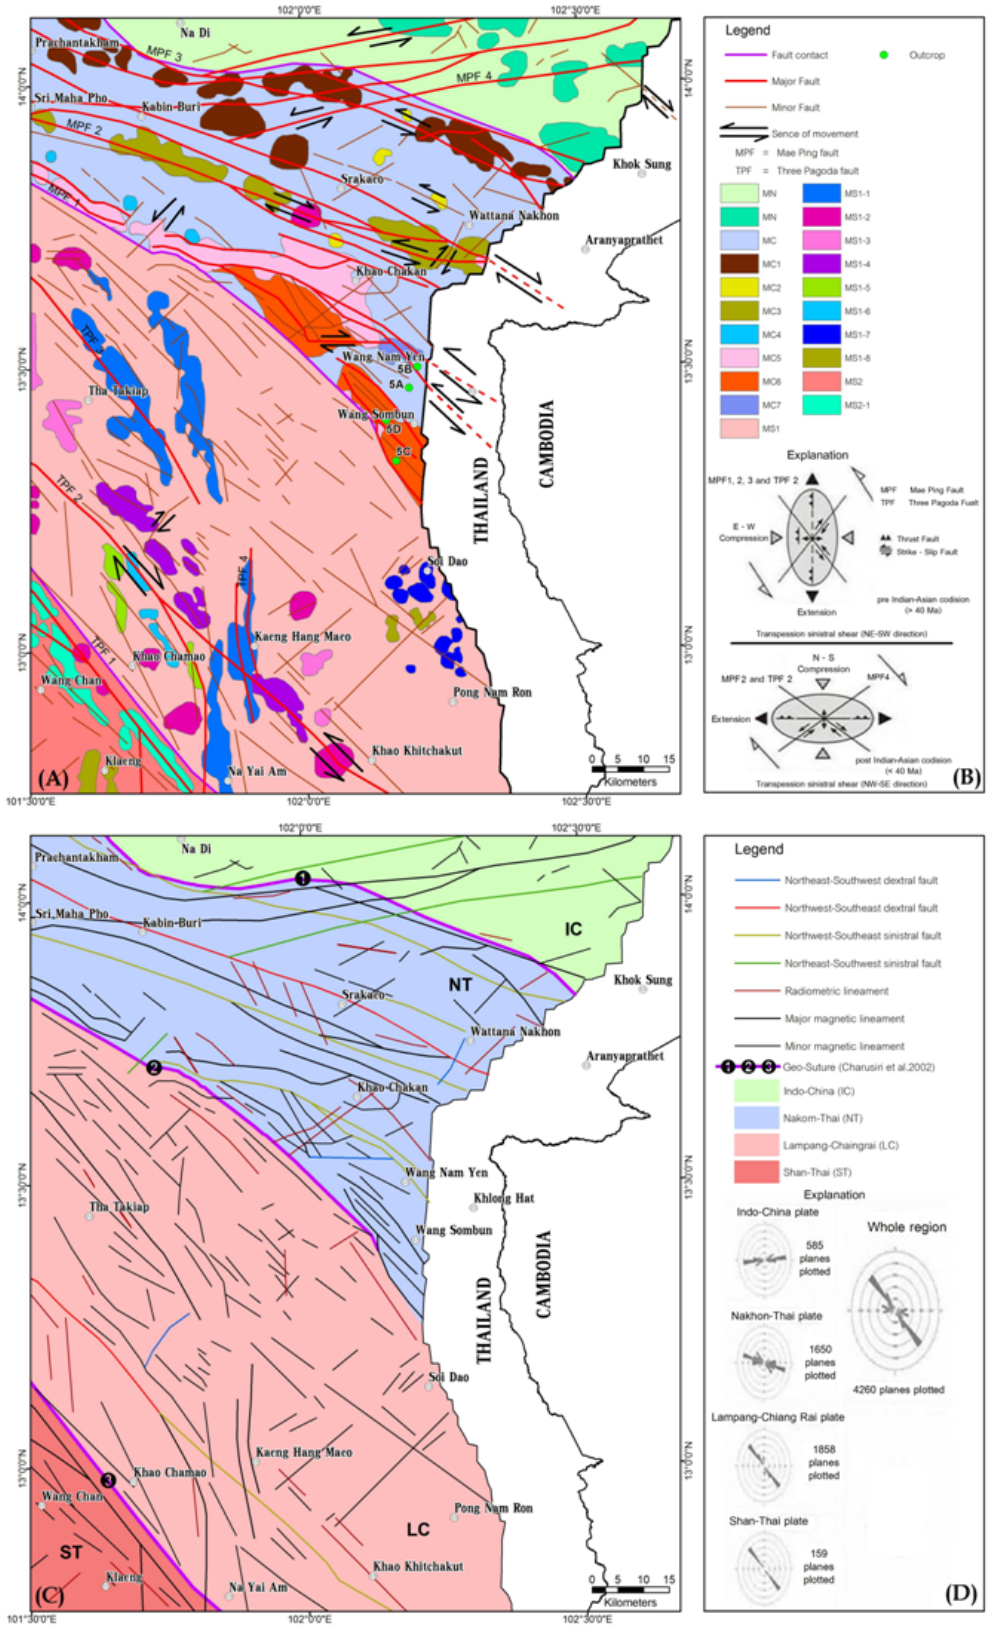
Figure 4. (A) Magnetic interpretation maps of the studied region in eastern Thailand showing the contrasting tectonic units, from the north to the south: the Indo-china (MN), Nakhon-Thai (MC), Lampang-Chiang Rai (MS1) and Shan-Thai (MS2) plates corresponding to the magnetic domains. (B) Strain ellipsoids showing the east-west compression and development of MPF1, MPF3 and TPF2 during the pre Indian-Asian collision in (A) and the transpression sinistral shear in a northwest-southeast direction with the development of MPF2, MPF4 and TPF2 during the post Indian-Asian collision in (B). (C) Structural map (based on data of A and B), and (D) Rose diagrams showing the major lineament patterns of the Indo-china (MN), Nakhon-Thai (MC), Lampang-Chiang Rai (MS1) and Shan-Thai (MS2) tectonic